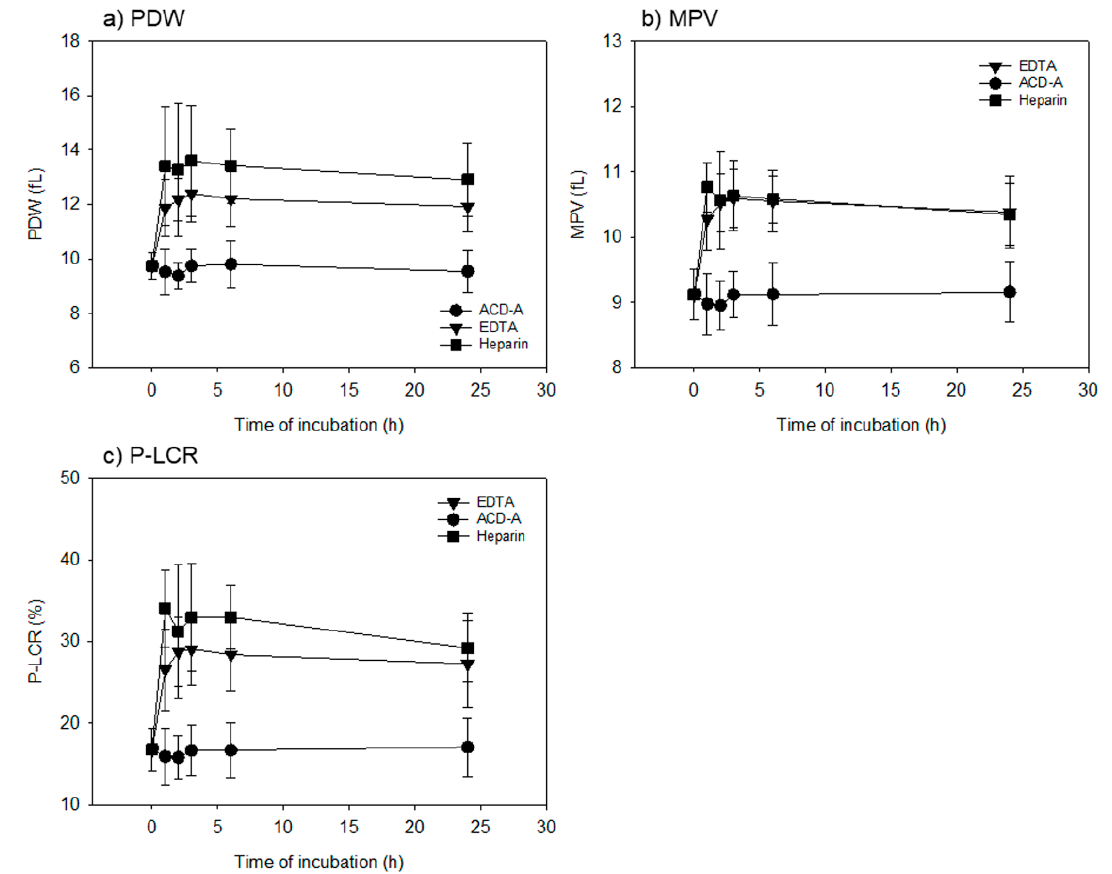
Figure 2. Time-course effects of anticoagulants on platelet size (platelet distribution width, mean platelet volume and platelet-large cell ratio) in whole-blood samples. Whole-blood samples were stored following mild mixing at room temperature for up to 24 h. ( a ) platelet distribution width. ( b ) Mean platelet volume. ( c ) platelet–large cell ratio. In all the parameters, EDTA and heparin anticoagulation treatments significantly increased platelet distribution width (vs. ACD-A anticoagulation treatments) at the same time points from 1 to 24 h. n = 15.